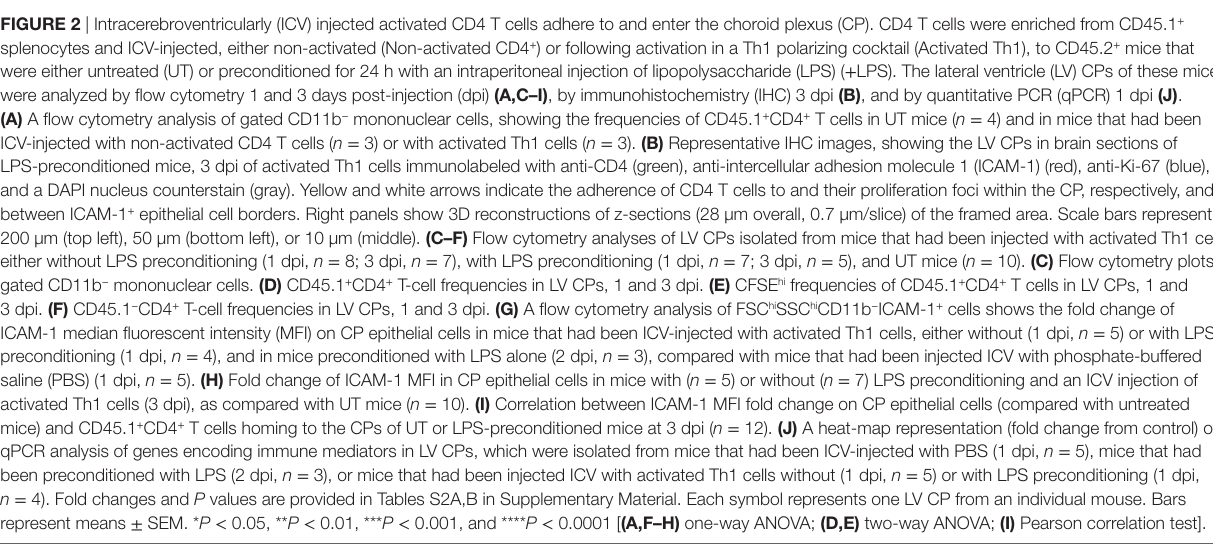
FigUre 2 | Intracerebroventricularly (ICV) injected activated CD4 T cells adhere to and enter the choroid plexus (CP). CD4 T cells were enriched from CD45.1 + splenocytes and ICV-injected, either non-activated (Non-activated CD4 + ) or following activation in a Th1 polarizing cocktail (Activated Th1), to CD45.2 + mice that were either untreated (UT) or preconditioned for 24 h with an intraperitoneal injection of lipopolysaccharide (LPS) ( + LPS). The lateral ventricle (LV) CPs of these mice were analyzed by flow cytometry 1 and 3 days post-injection (dpi) (a,c–i) , by immunohistochemistry (IHC) 3 dpi (B) , and by quantitative PCR (qPCR) 1 dpi (J) . (a) A flow cytometry analysis of gated CD11b − mononuclear cells, showing the frequencies of CD45.1 + CD4 + T cells in UT mice ( n = 4) and in mice that had been ICV-injected with non-activated CD4 T cells ( n = 3) or with activated Th1 cells ( n = 3). (B) Representative IHC images, showing the LV CPs in brain sections of LPS-preconditioned mice, 3 dpi of activated Th1 cells immunolabeled with anti-CD4 (green), anti-intercellular adhesion molecule 1 (ICAM-1) (red), anti-Ki-67 (blue), and a DAPI nucleus counterstain (gray). Yellow and white arrows indicate the adherence of CD4 T cells to and their proliferation foci within the CP, respectively, and between ICAM-1 + epithelial cell borders. Right panels show 3D reconstructions of z-sections (28 µm overall, 0.7 µm/slice) of the framed area. Scale bars represent 200 µm (top left), 50 µm (bottom left), or 10 µm (middle). (c–F) Flow cytometry analyses of LV CPs isolated from mice that had been injected with activated Th1 cells, either without LPS preconditioning (1 dpi, n = 8; 3 dpi, n = 7), with LPS preconditioning (1 dpi, n = 7; 3 dpi, n = 5), and UT mice ( n = 10). (c) Flow cytometry plots of gated CD11b − mononuclear cells. (D) CD45.1 + CD4 + T-cell frequencies in LV CPs, 1 and 3 dpi. (e) CFSE hi frequencies of CD45.1 + CD4 + T cells in LV CPs, 1 and 3 dpi. (F) CD45.1 − CD4 + T-cell frequencies in LV CPs, 1 and 3 dpi. (g) A flow cytometry analysis of FSC hi SSC hi CD11b − ICAM-1 + cells shows the fold change of ICAM-1 median fluorescent intensity (MFI) on CP epithelial cells in mice that had been ICV-injected with activated Th1 cells, either without (1 dpi, n = 5) or with